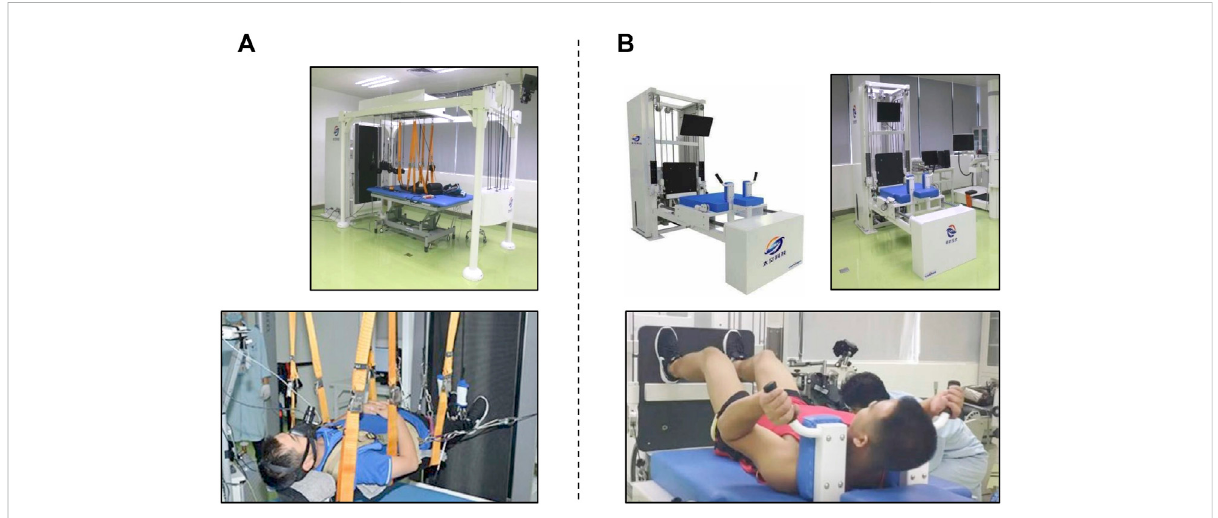
FIGURE 2 Exercise countermeasures. Treadmill training (A). A vertically tilted treadmill allows the subject to perform moderate- and high-intensity running while remaining supine. Exercise protocol: moderate running (60% – 80% _ VO 2 max) for 30 min 3x/week and 4 sets of high-intensity running (90% _ VO 2 max) for 4 min once a week. Resistance training (B) . A vertically tilted resistance exercise platform allows the subject to perform resistance exercises (squats, heel raises, shoulder shrugs, and curls) while remaining supine. Exercise protocol: 3 sets of 10 – 12 repetitions (60% – 80%max voluntary contraction), 45 min